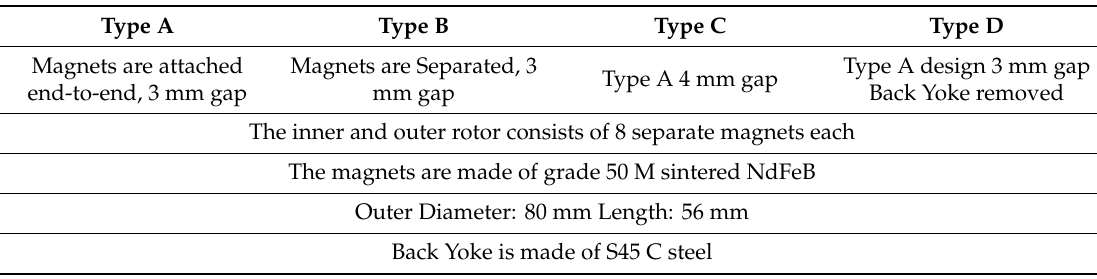
Table 2. Summary of the Magnetic Coupling